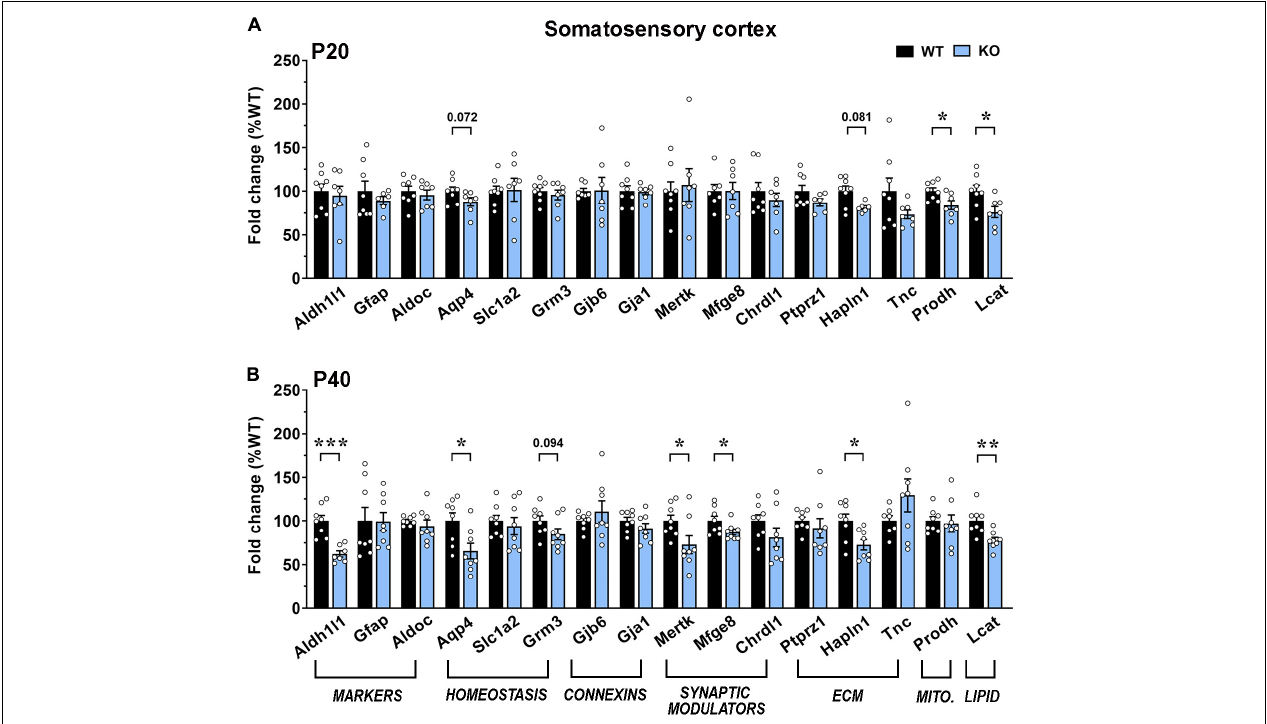
FIGURE 7 | Transcriptional expression of astrocytic genes in the somatosensory cortex of early-symptomatic and moderate symptomatic Mecp2 KO animals. (A,B) The graphs depict the mRNA expression of selected astrocytic genes in somatosensory cortex of early-symptomatic [at P20 (A) ] and moderate symptomatic [at P40 (B) ] KO mice, compared to the corresponding WT littermates. Data are represented as mean ± SEM. * p < 0.05; ** p < 0.01; *** p < 0.001 by Student’s t -test or Mann–Whitney test in accordance with data distribution. Eight animals per genotype were used at each time point ( N =